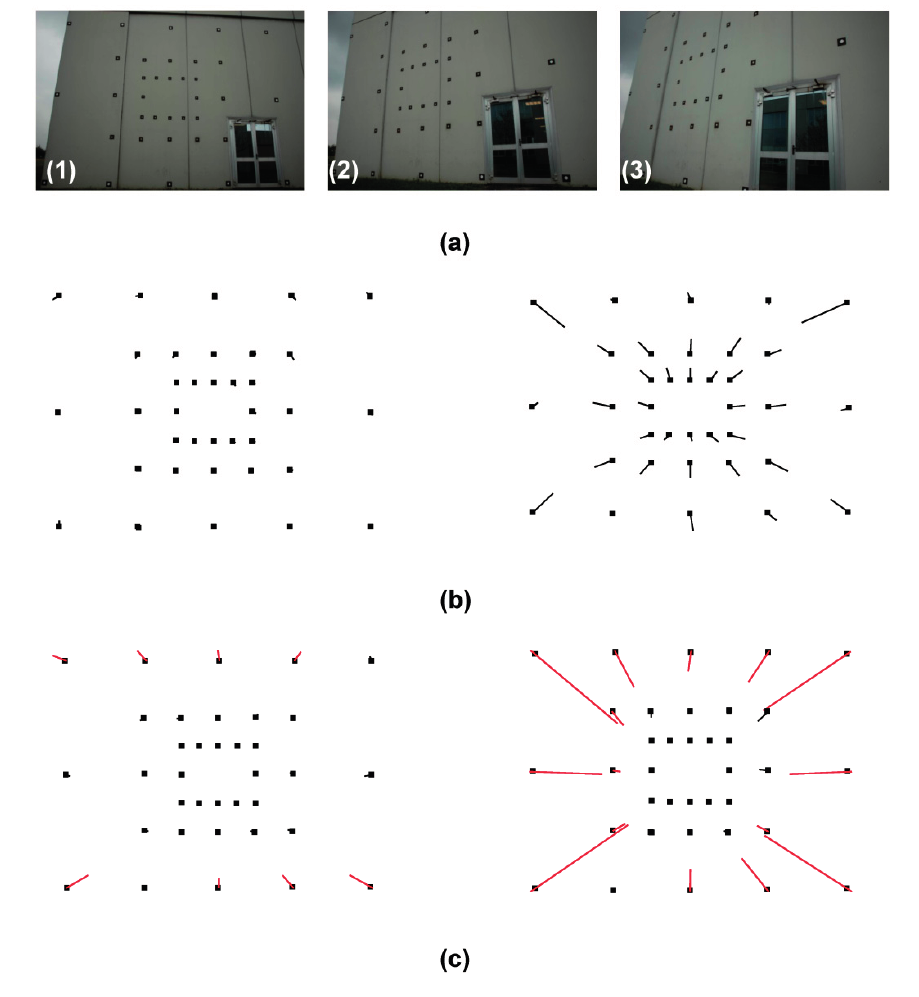
Figure 2. ( a ) Three different views the first of the calibration test field formed by 36 Ground Control Points (GCPs). The tilt of the images increases from left to right; ( b ) Residuals obtained on the Check Points (CPs), with (left) and without (right) camera distortion correction, by using all the available CPs; ( c ) Residuals obtained on the CPs, with (left) and without (right) camera distortion correction, by using only the central